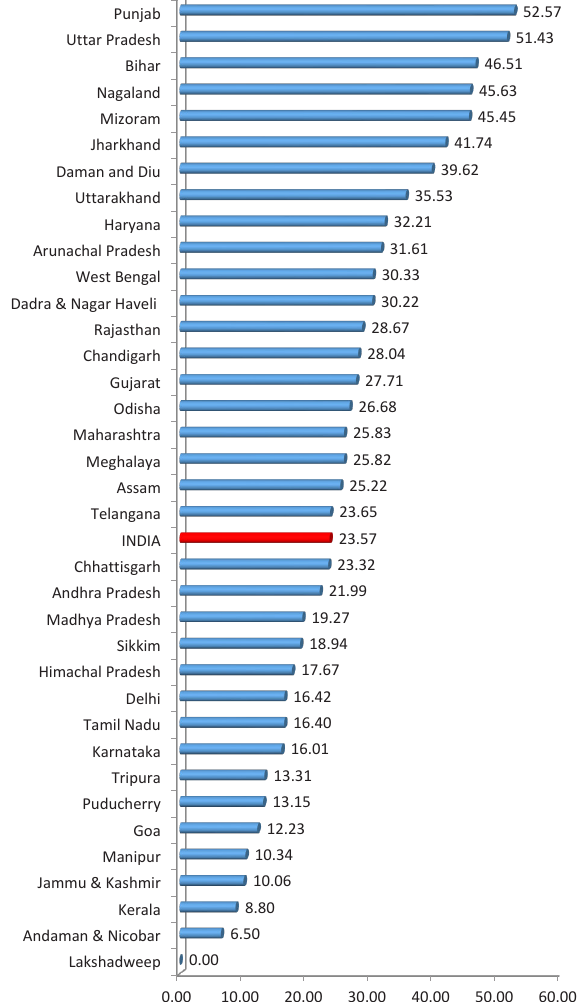
Figure 1. State-wise fatality rate among total road traffic accident victims in India in the year